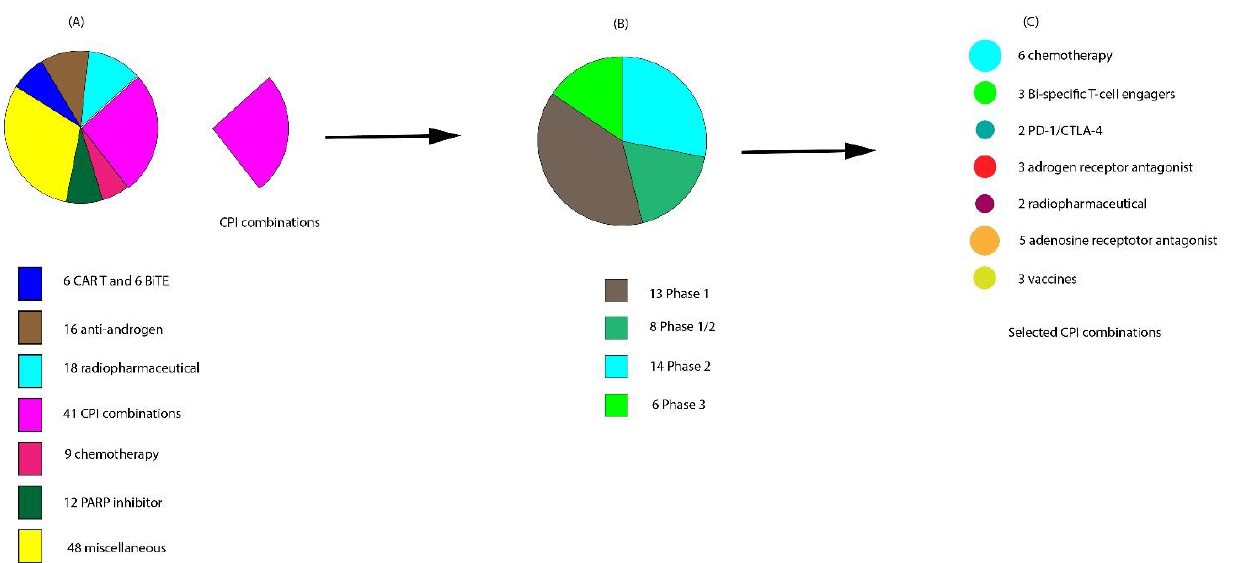
Figure 3. Snapshot of ongoing interventional clinical trials actively recruiting patients with metastatic castration-resistant prostate cancer (mCRPC) in July 2020. ( A ) Breakdown of the 150 clinical trials ongoing. ( B ) Of the 41 checkpoint inhibitor (CPI) trials, 13 are in phase I, 8 in phase I/II, 14 in phase II, and 6 in phase III. ( C ) The agents currently being used for CPI combinatorial therapy.